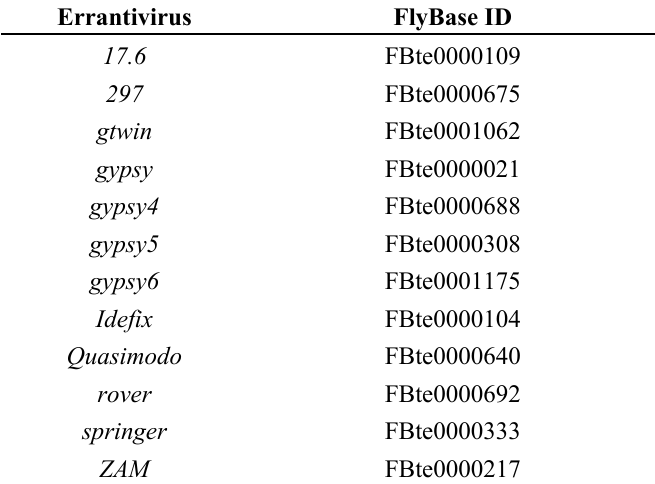
Table 1. Names and Flybase IDs of errantiviruses regulated by flamenco in Drosophila melanogaster follicle cells